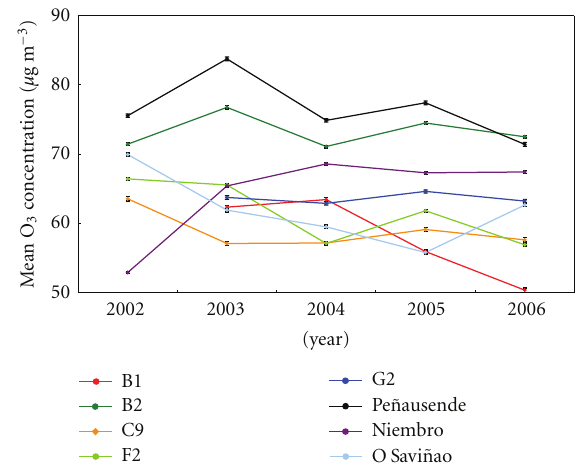
Figure 5: Series of annual mean 24-h ozone concentrations throughout the 5-year-study period (2002–2006) for each site.